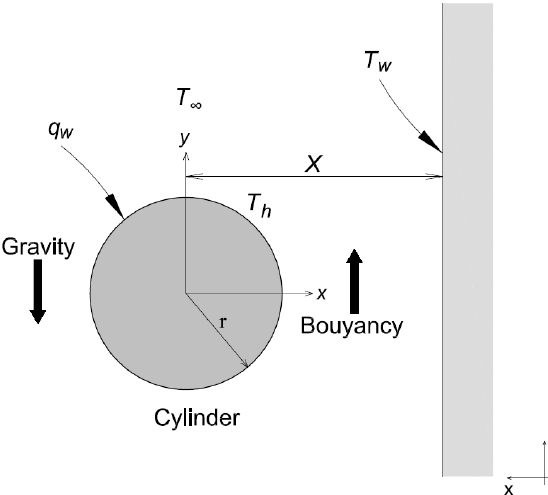
Fig. 3. Heated circular cylinder near an isothermal wall